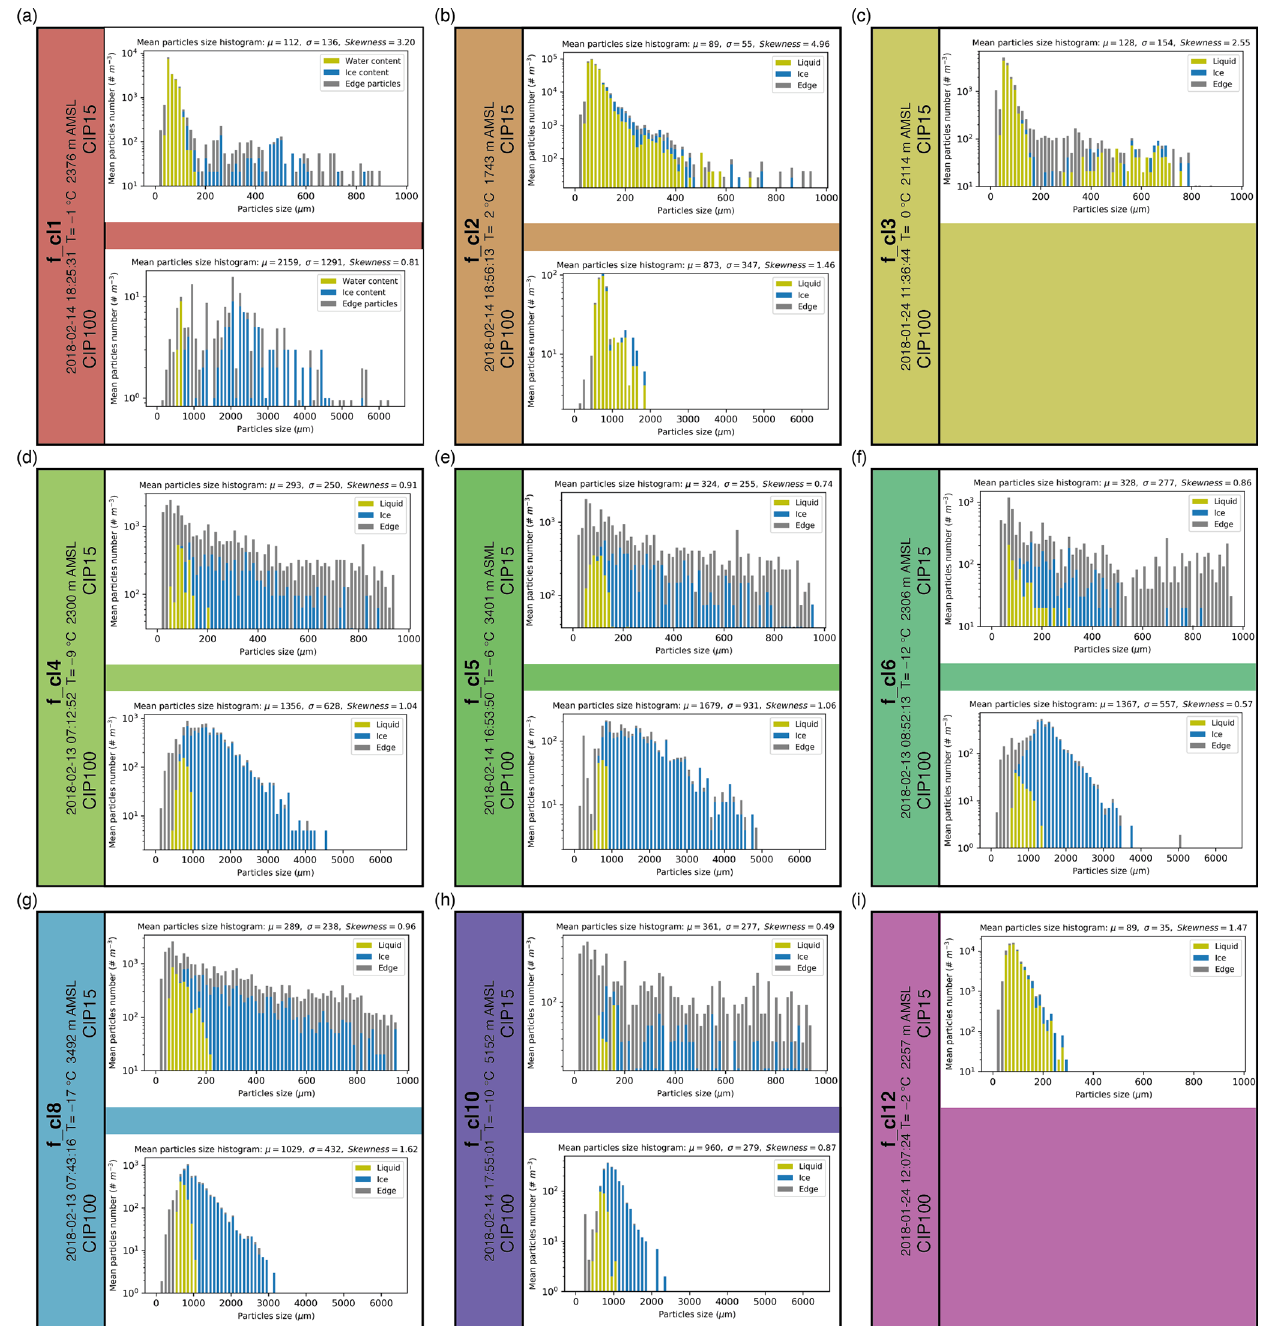
Figure 10. Corresponding to Fig. 9, particle size distributions from the cloud image probe CIP-15 (15µm, upper) and CIP-100 (100µm, lower) within a 30km range of the radar position: (a) for f_cl1 – at 18:25:31UTC on 14 February 2018; (b) for f_cl2 – at 18:56:13UTC on